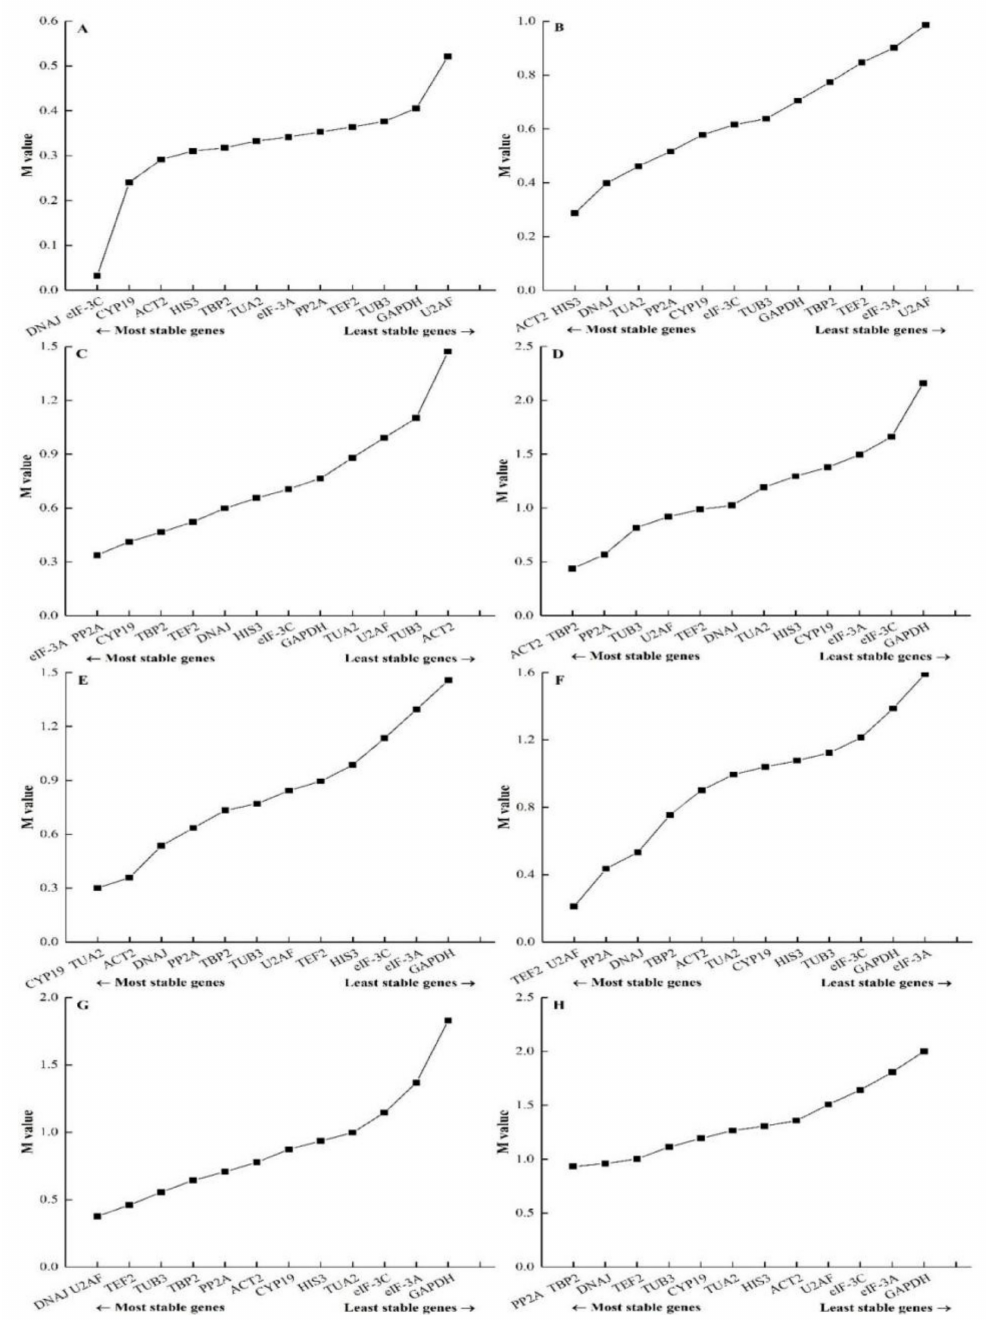
Figure 3. Average expression stability values (M) of 13 candidate reference genes under di ff erent conditions calculated by geNorm. ( A ) Di ff erent genotypes, ( B ) di ff erent developmental stages, ( C ) di ff erent tissues, ( D ) salt stress, ( E ) heat stress, ( F ) cold stress, ( G ) osmotic stress, and ( H ) all